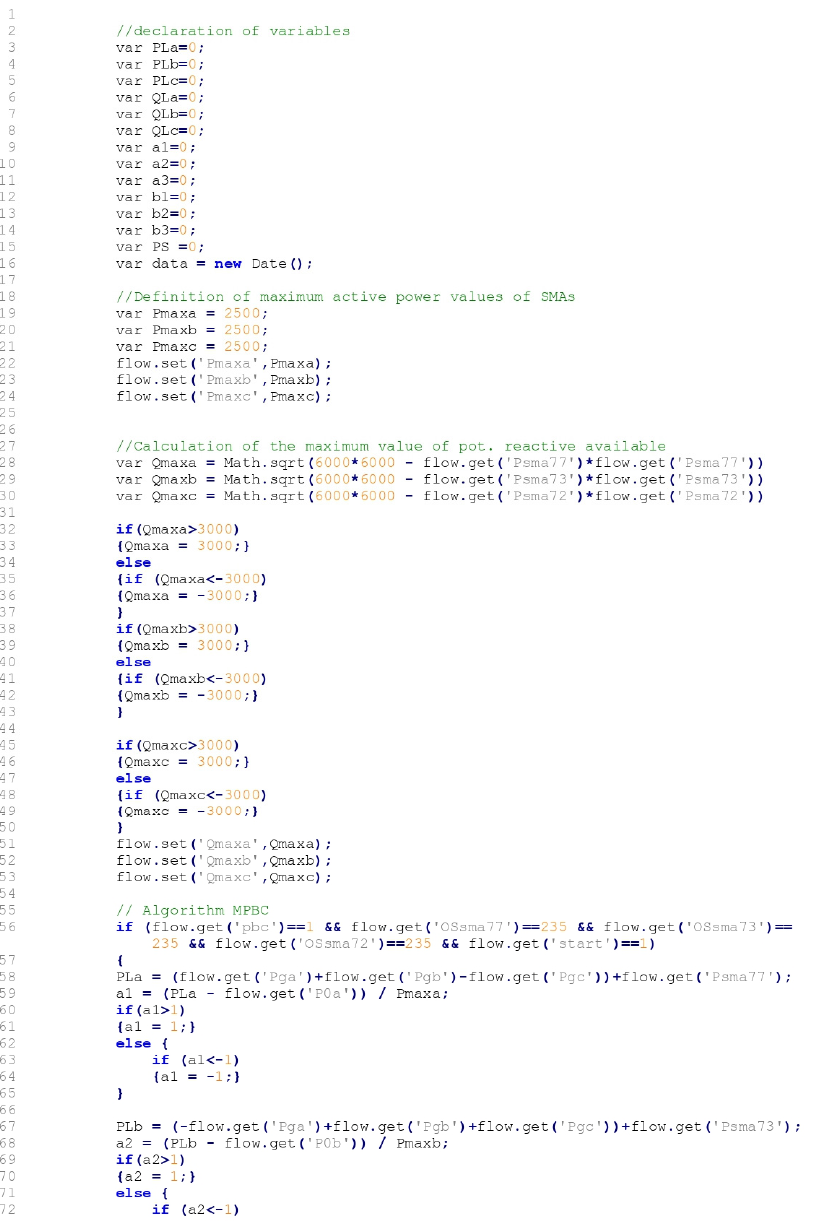
Figure A1: Part 1 of the MPBC algorithm developed in the Node-RED tool. Figure A1. Part 1 of the MPBC algorithm developed in the Node-RED